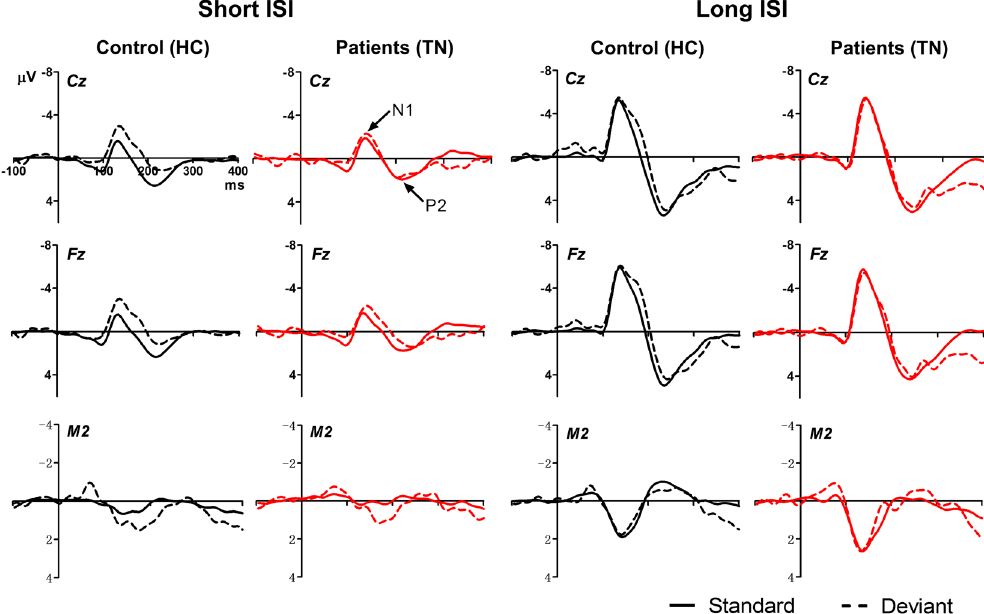
Figure 1. ERPs produced in response to standard and deviant tones in Experiment 1. Grand average waveforms for TN patients (red) and HCs (black) are shown for Cz, Fz, and M2 electrodes under short- (left panel) and long-ISI (right panel)